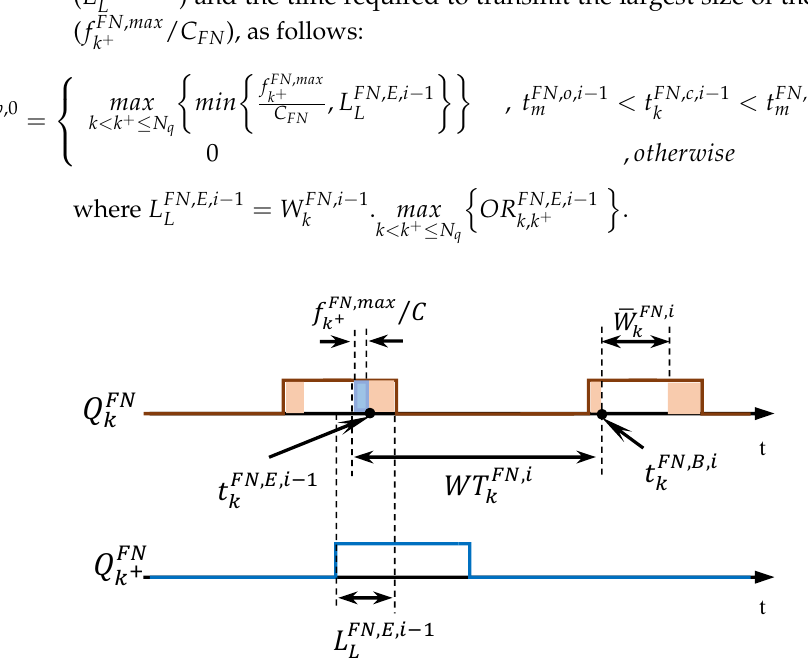
Figure 10. The maximum waiting time at the first node.